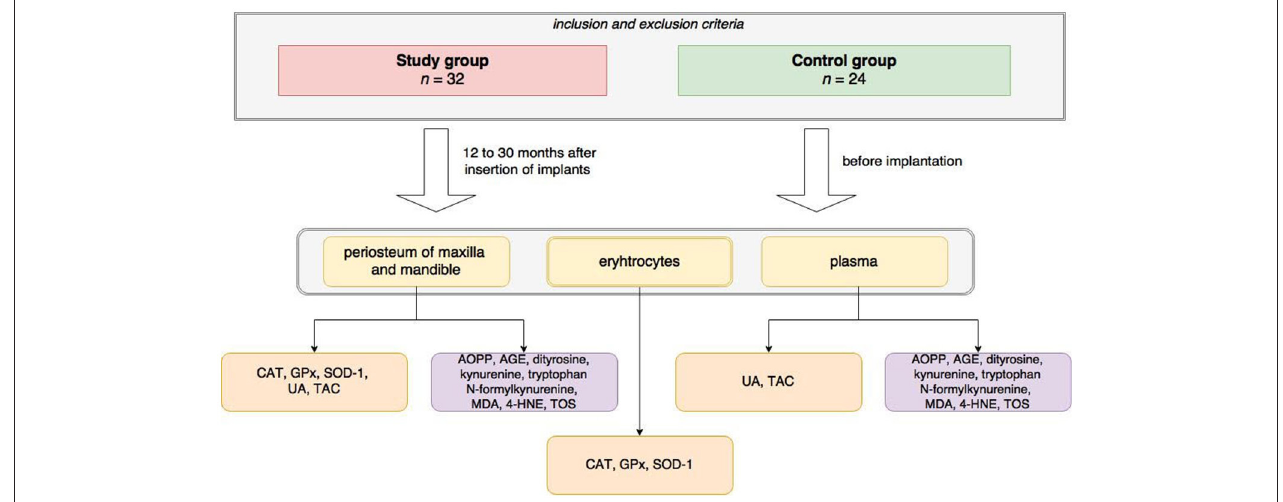
FIGURE 1 | Graphical representation of the experiment scheme. In the research material (periosteum of maxilla and mandible, erythrocytes and plasma) in the study and control group were evaluated: activity/concentrations of some antioxidants (SOD-1, superoxide dismutase-1; GPx, glutathione peroxidase; CAT, catalase; UA, uric acid; TAC, total antioxidant capacity) as well as oxidative modification products (AGE, advanced glycation end products; AOPP, advanced oxidation protein products, MDA, malondialdehyde, TOC, total oxidant capacity).